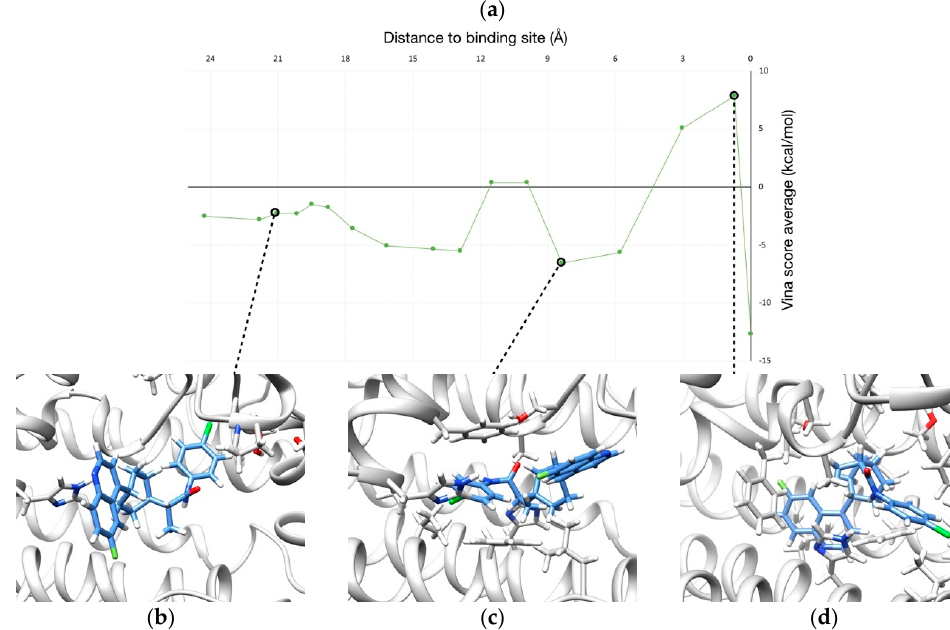
Figure 6. ( a ) Profile of binding energy (i.e., Vina score) along the binding pathway of BMS. ( b – d ) Three representative snapshots of the binding route are